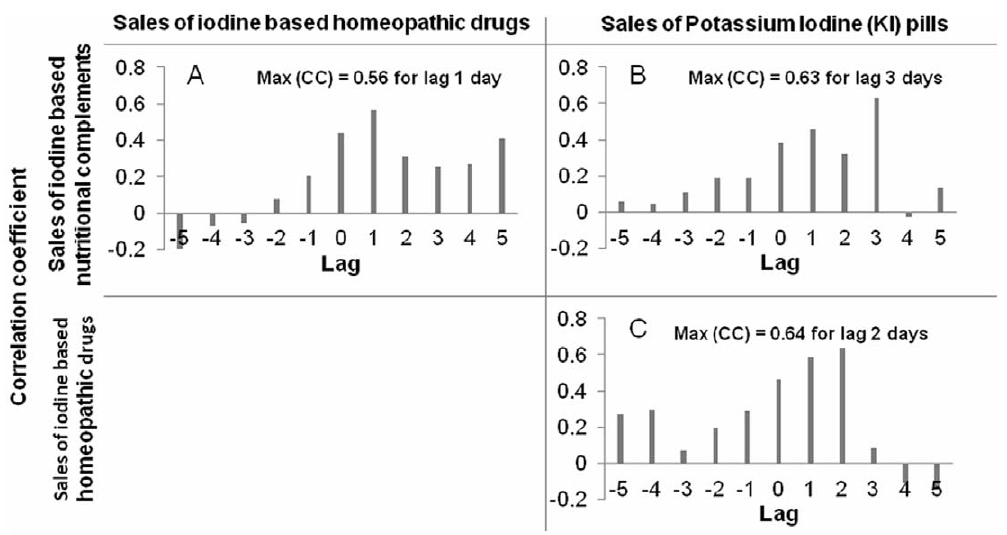
Figure 3. Cross-correlograms of sales of iodine based nutritional complements (INC), homeopathic drugs (H), and Potassium Iodide (KI) pills with lags from 2 5 to + 5 days on the period from March 1 st 2011 to April 10 th 2011. a) Cross-correlations show that sales of INC preceded sales of H. by 1 day. b) Cross-correlations show that sales of INC preceded sales of KI by 3 days. c) Cross-correlations show that sales of H. preceded sales of KI by 2 days.